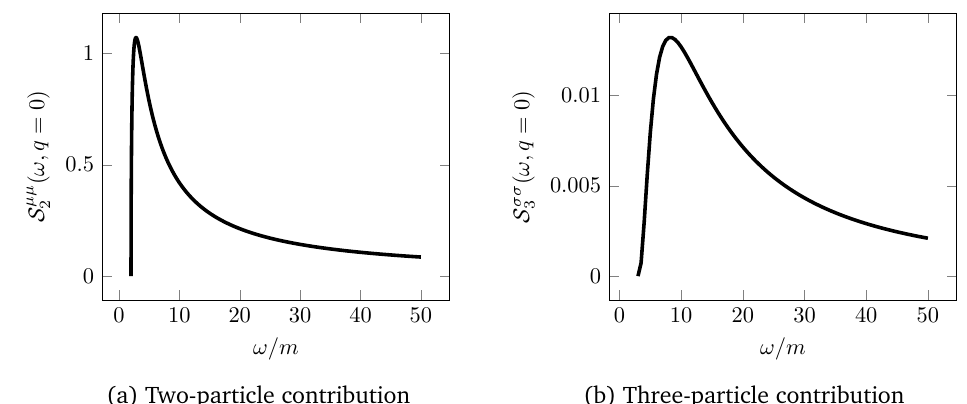
Figure 2.1: Two- and three particle contributions to the dynamical structure factor of disorder (a) and order operators (b) in the Ising model. The values of the dynamical structure factors are shown in units of the mass gap m using the expression (2.36) for F 0